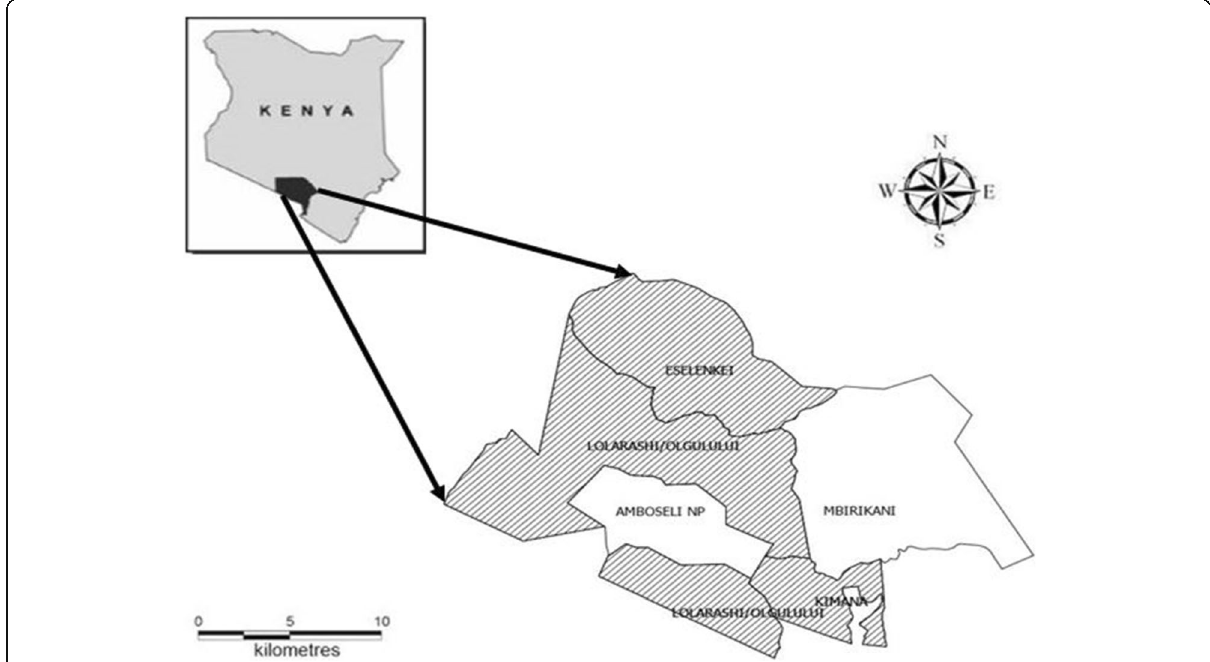
Fig. 1 The Amboseli ecosystem (Amboseli National Park and surrounding group